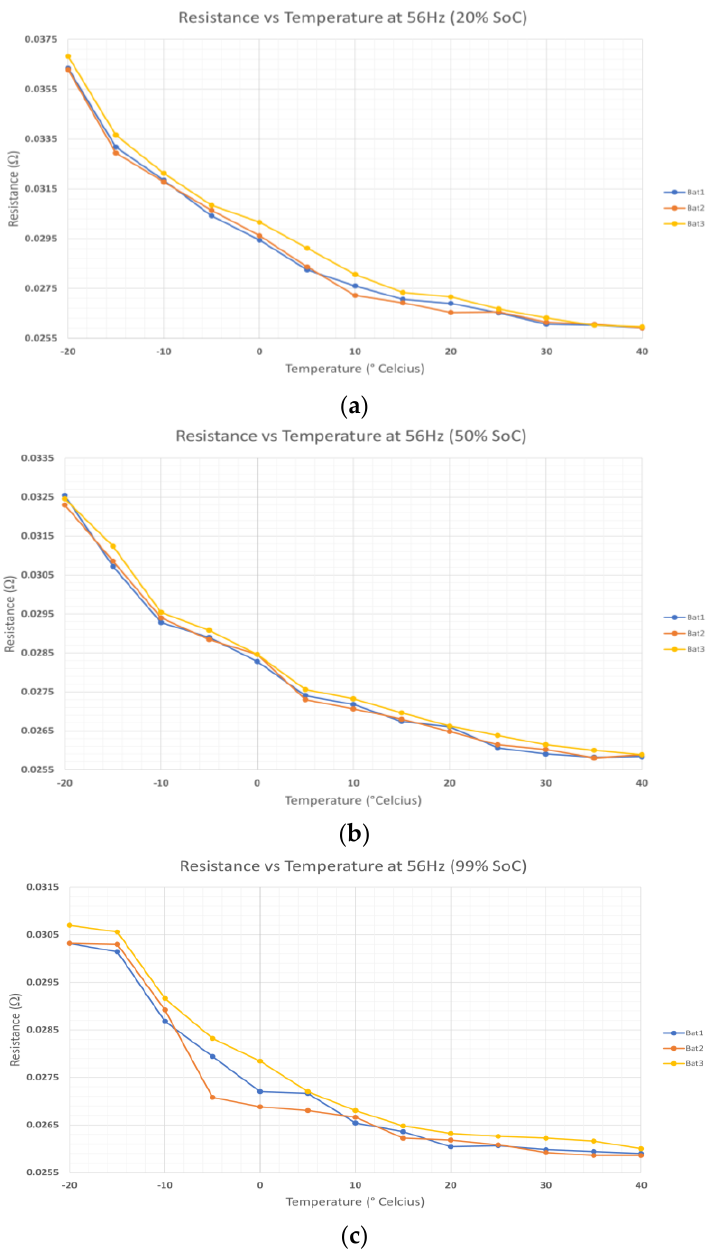
Figure 11. Batteries’ impedance data: ( a ) at 20%; ( b ) at 50%; ( c ) at 99% SoC level.